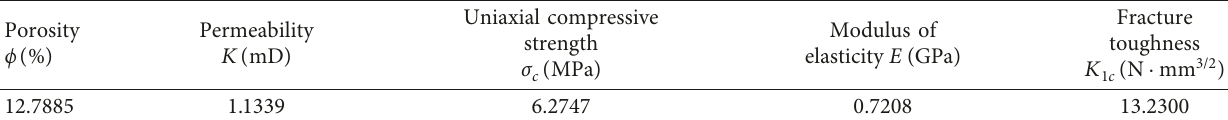
Figure 2: The true triaxial hydraulic fracturing experiment system. (a) Block diagram. (b) Physical photo. Table 1: Physical and mechanical parameters of the cement